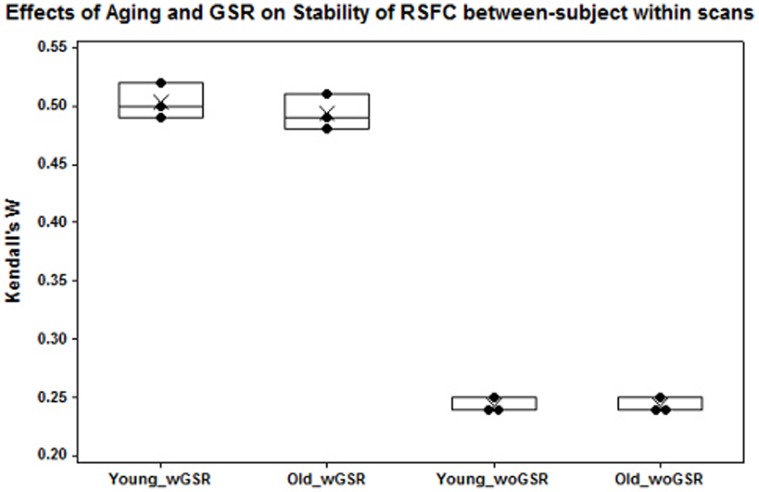
Effects of aging and GSR on stability of RSFC between-subject within scan.GSR could potentially enhance the agreement/stability across scan sessions from subject to subject. Each black dot represents Kendall’s W between subjects within each scan. Cross points represent Kendall’s W values averaged across three scans.